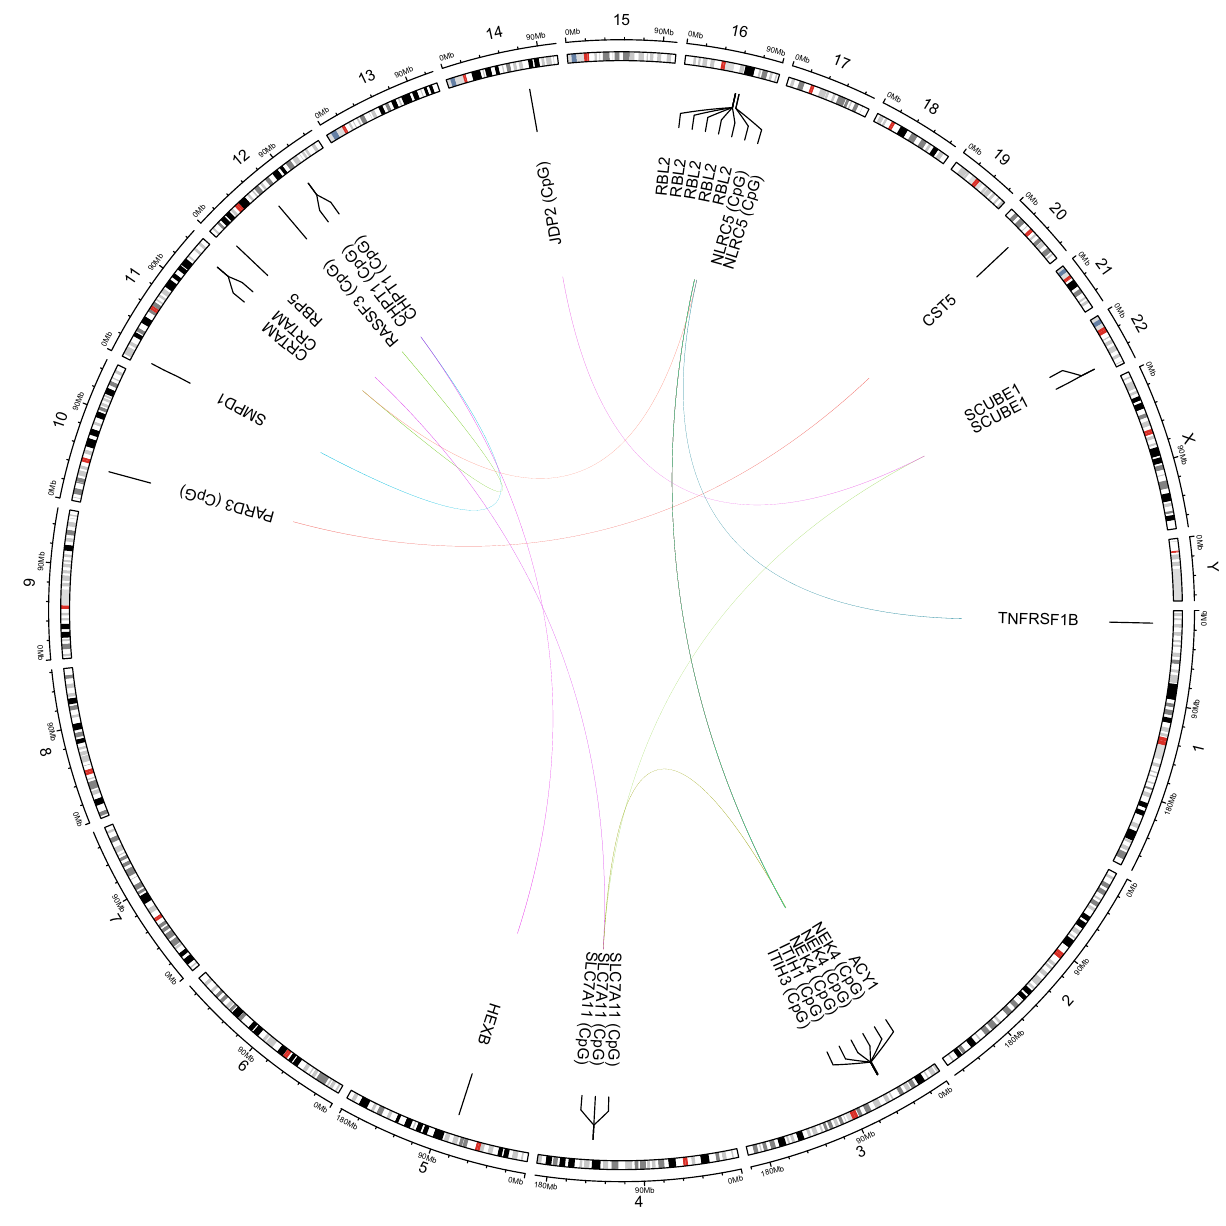
Fig. 5 | Trans pQTMs involving protein markers of brain health. Circular plot showing15 trans pQTMassociationsbetweenDNAmat11CpGsitesandthelevelsof nine protein markers of brain health that had P <4.5×10 − 10 (Bonferroni threshold for multiple testing adjustment) in the fully-adjusted MWAS. Chromosomal